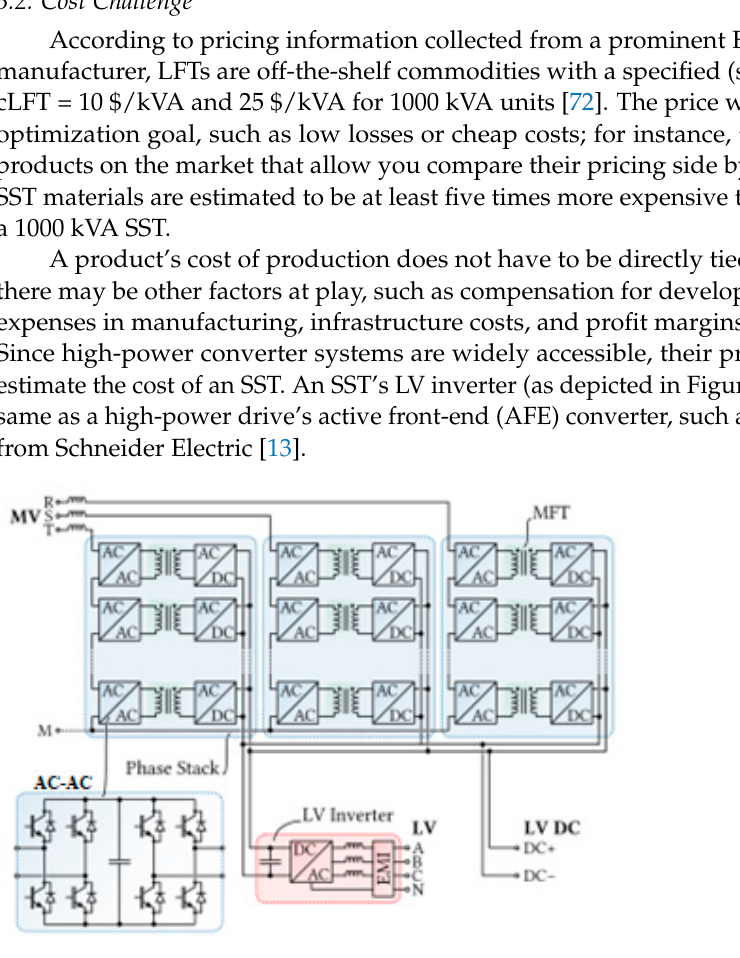
Figure 16. ( a ) Cost analysis of a 1000 kVA AC–AC SST which is at least 5 to 10 times that of a simi- larly rated LFT, ( b ) a comparison of a 500 kVA LV inverter’s projected material costs with list price information from [15,75]. Reprinted with permission from Ref. [15]. 2022, IEEE. The weight and material cost structures of the MV converter, the LV converter, and the combined 1000 kVA AC–AC SST are shown in Figure 17. It is noteworthy that low- frequency magnetic components, such as filter inductors, continue to account for a sizable portion of both weight and material costs, particularly in the case of LV converters, where